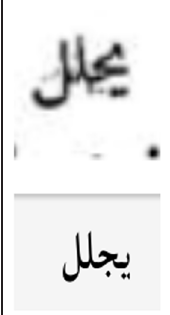
Figure 27: Example of poor scan quality—black shading in background of letters.